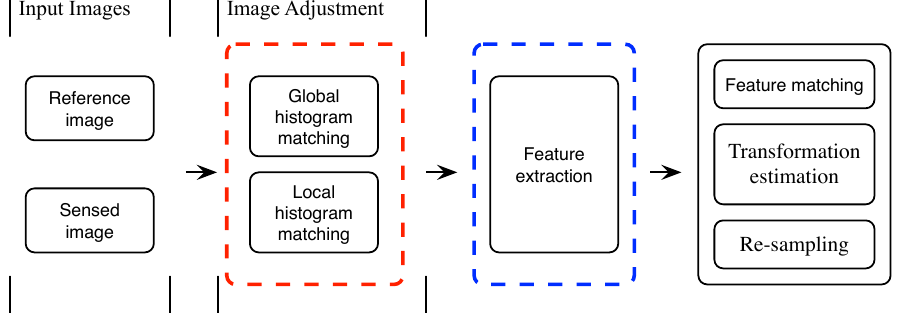
Figure 3. Flow chart of the proposed registration steps: the red box indicates image adjustment, while the blue box indicates feature